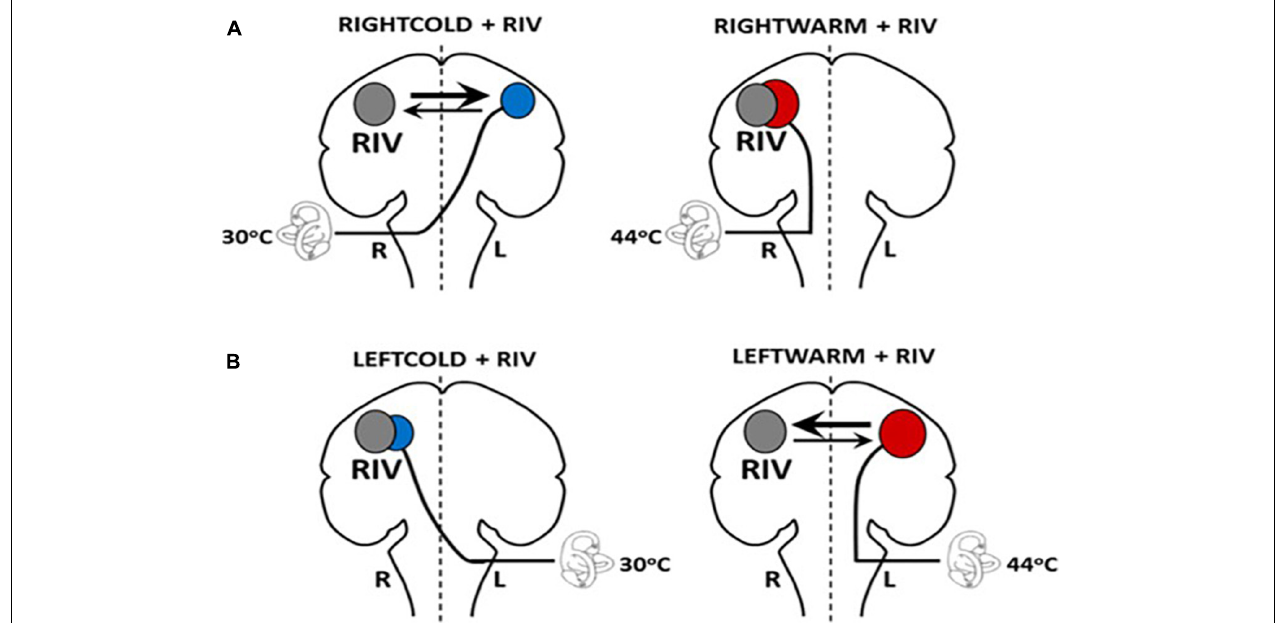
FIGURE 2 | Schematic model illustrating hemispheric activation during CALORIC + RIV stimulation: perceptual switching during binocular rivalry activates the right hemisphere (gray circle). Hemispheric activations following caloric stimulation are shown by the red circle following warm irrigations or by blue circles following cold irrigations. The labyrinth represents the side of the caloric irrigation. The size of the circles illustrates the relative degree of the activation. (A) During RIGHTCOLD + RIV, the hemispheres are in conflict; however, the right hemisphere exerts a predominant effect (as shown by the relative thickness of the arrows). No interhemispheric conflict occurs during either RIGHTWARM + RIV as both stimuli activate the right hemisphere. (B) Similarly, no conflict is present in LEFTCOLD + RIV condition, whereas during the LEFTWARM + RIV condition, conflict presents, but critically here the left hemisphere exerts a greater